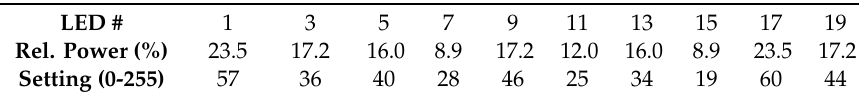
Table 1. Optimized values for the LED power and required settings. Due to variations in the individual radiance of the LEDs, some of them had to be operated at di ff erent currents to obtain the same output power. LEDs are numbered as they are in Figure 6a.